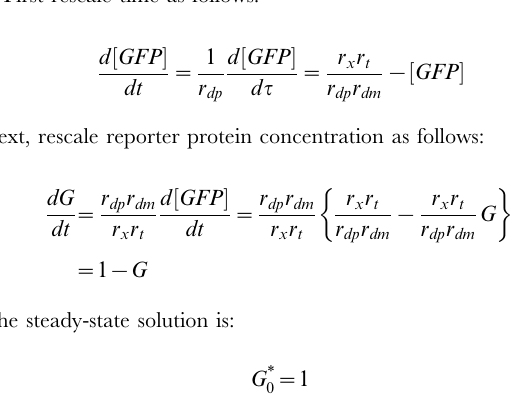
Fixed Points and Stability for the Individual Cases Case IA. Let G represent the protein level for the reporter (e.g.